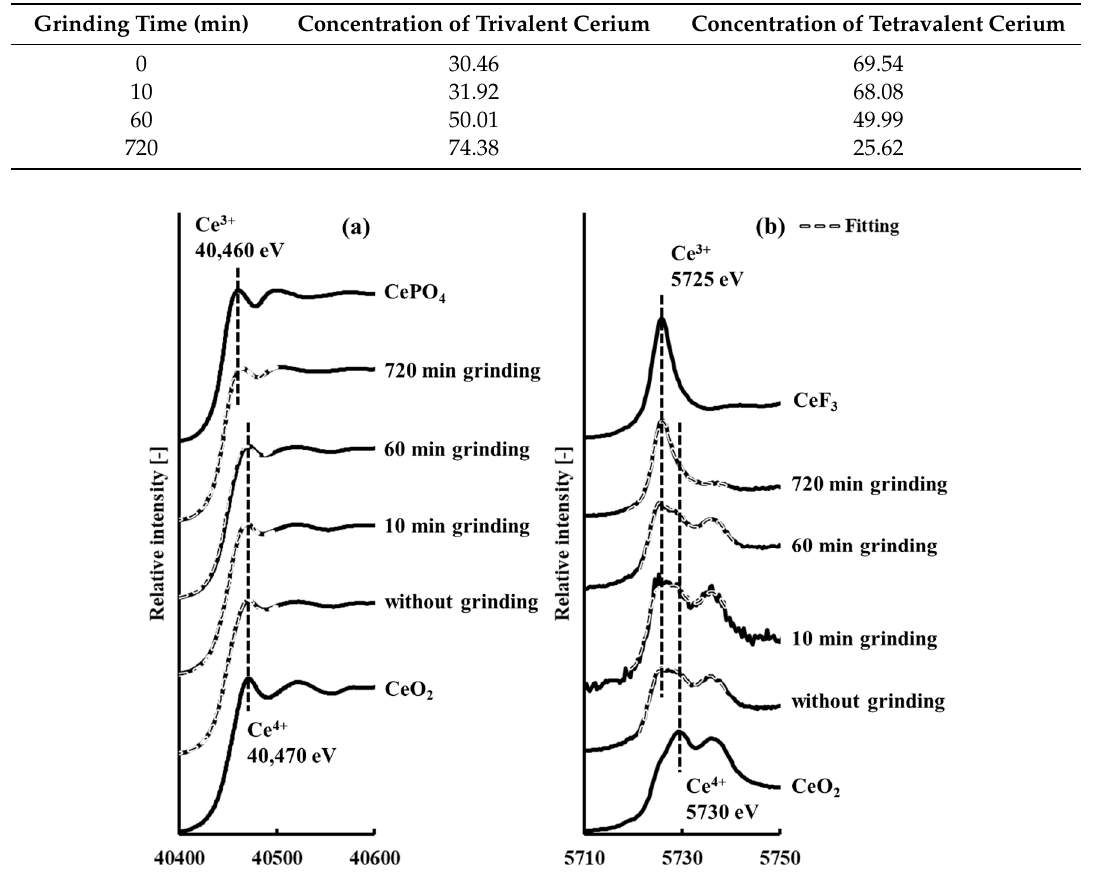
Table 5. Concentrations of tri- and tetravalent cerium in samples with and without grinding, based on X-ray absorption near-edge structure analysis at cerium K-edge (%).